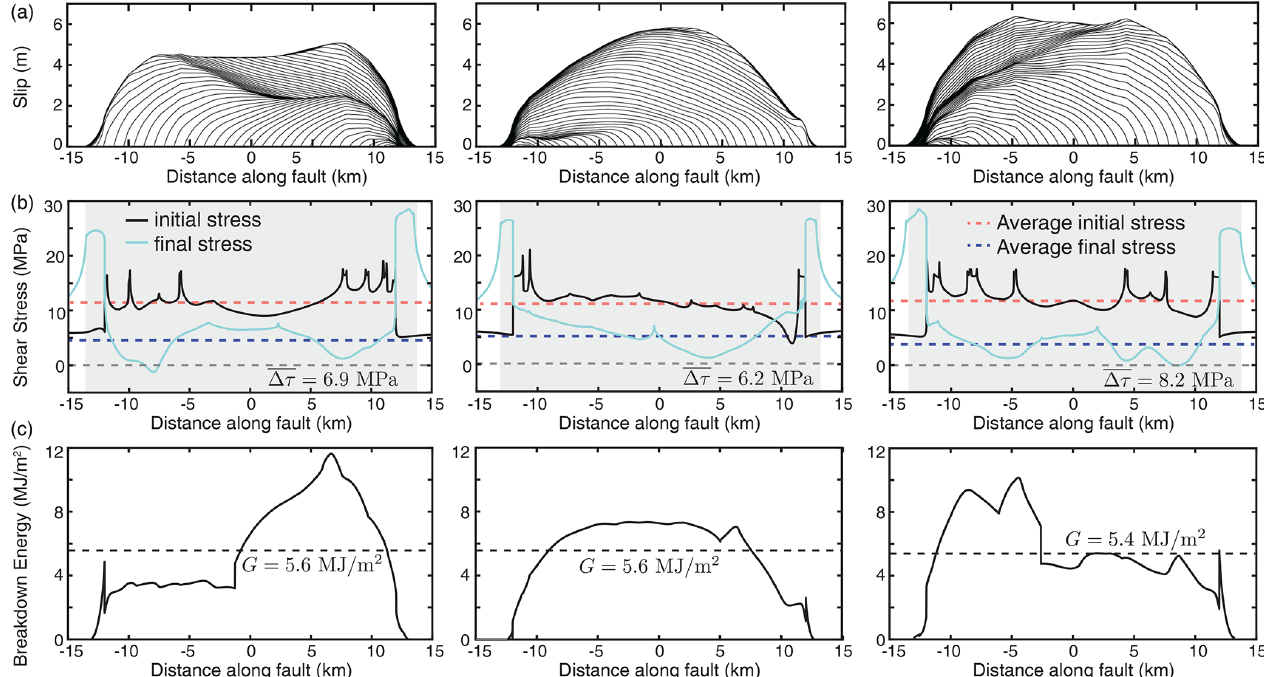
Figure 10. Comparison of the spatial breakdown energy distribution for the three large earthquake ruptures with nearly the same average breakdown energy and comparable average slip to Fig. 9. (a) Slip distributions for the three ruptures. (b) Spatial distributions of initial (solid black) and final (solid blue) shear stress for the three ruptures. Gray shading denotes the ruptured region and dashed red and blue lines indicate the average initial and final shear stresses, respectively. (c) Spatial distributions of the local breakdown energy. While the three ruptures have comparable average breakdown energy, the spatial variation throughout the rupture process considerably differs. Furthermore, the same spatial locations can have significantly different breakdown energy values in different rupture events of comparable